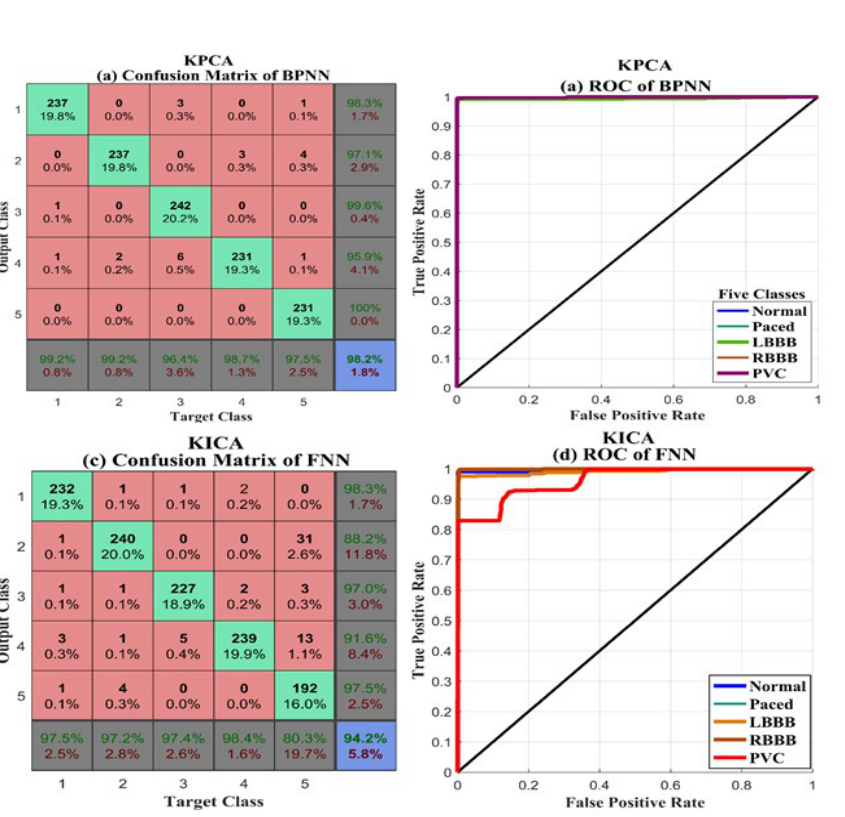
Figure 7 . Confusion matrix and ROC curve of BPNN using KPCA (a-b) and Confusion matrix and ROC curve of FNN using KICA